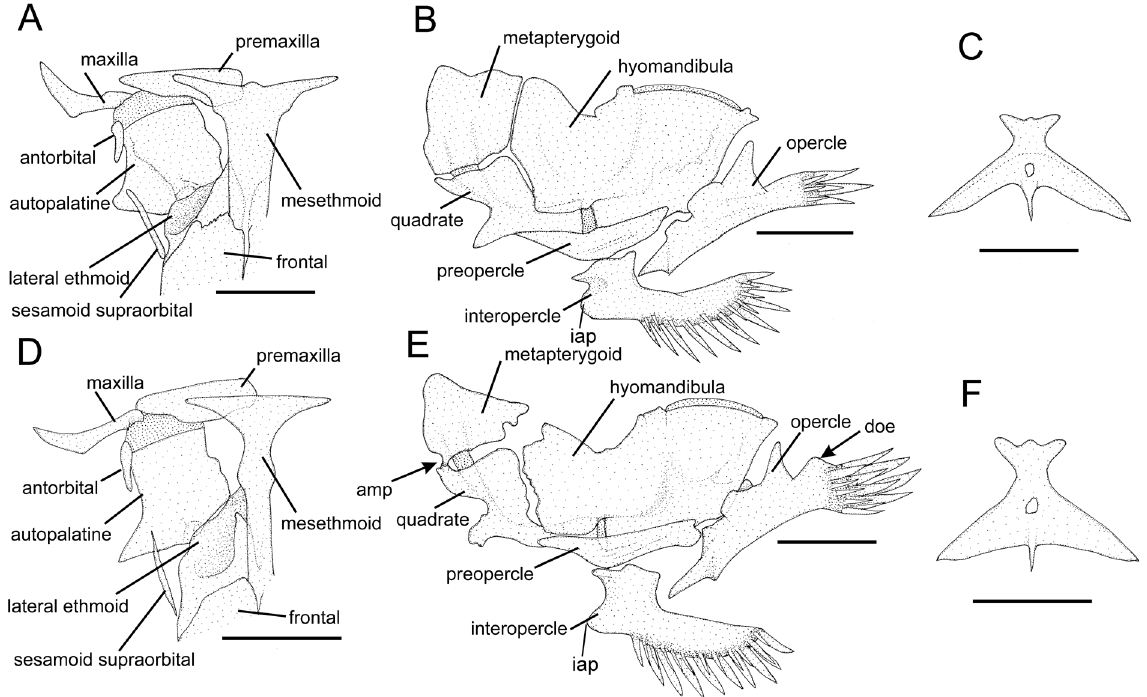
Fig. 2. Osteological structures. A–C . Cambeva alphabelardense sp. nov., paratype (UFRJ 6993). D–F . Cambeva betabelardense sp. nov., paratype (UFRJ 6996). A, D . Mesethmoidal region